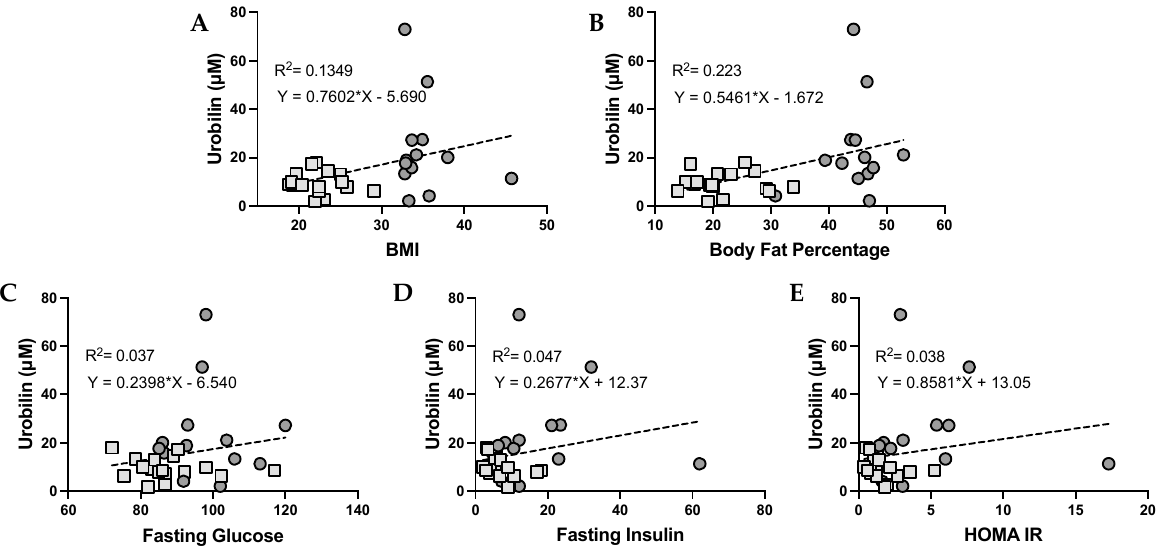
Figure 2. Urobilin levels and correlations with metabolic phenotypes in women and men . Com- parisons of metabolic phenotypes in women and men with plasma urobilin levels for ( A ) BMI, ( B ) body fat percentage, ( C ) blood glucose, ( D ) blood insulin, and ( E ) HOMA IR. The data were plotted as dot plots, linear regression was calculated, and the slope of the line was used to determine the relationship and the robustness of the data. Light gray squares are for lean women and men combined, and dark gray circles are for obese men and women combined.